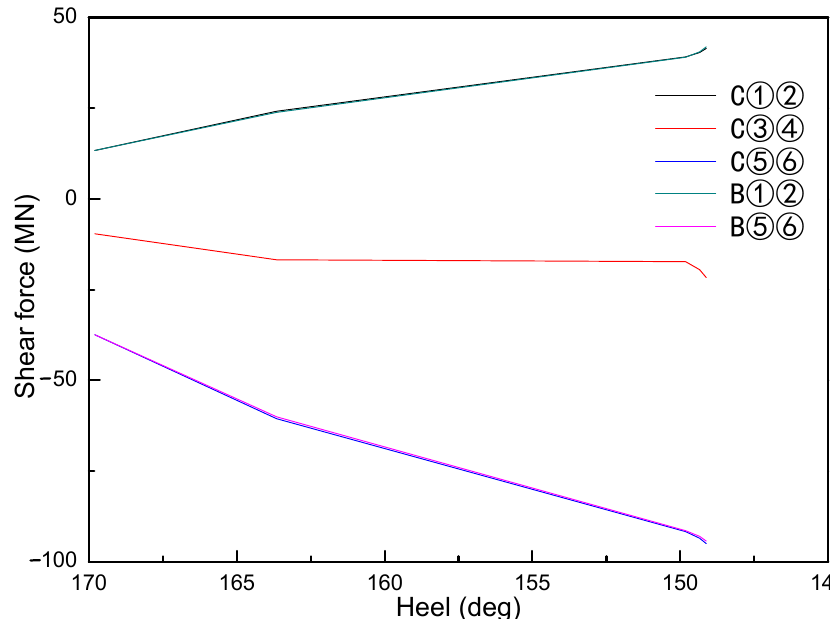
Figure 11. Variation of torque under case Ⅰ .